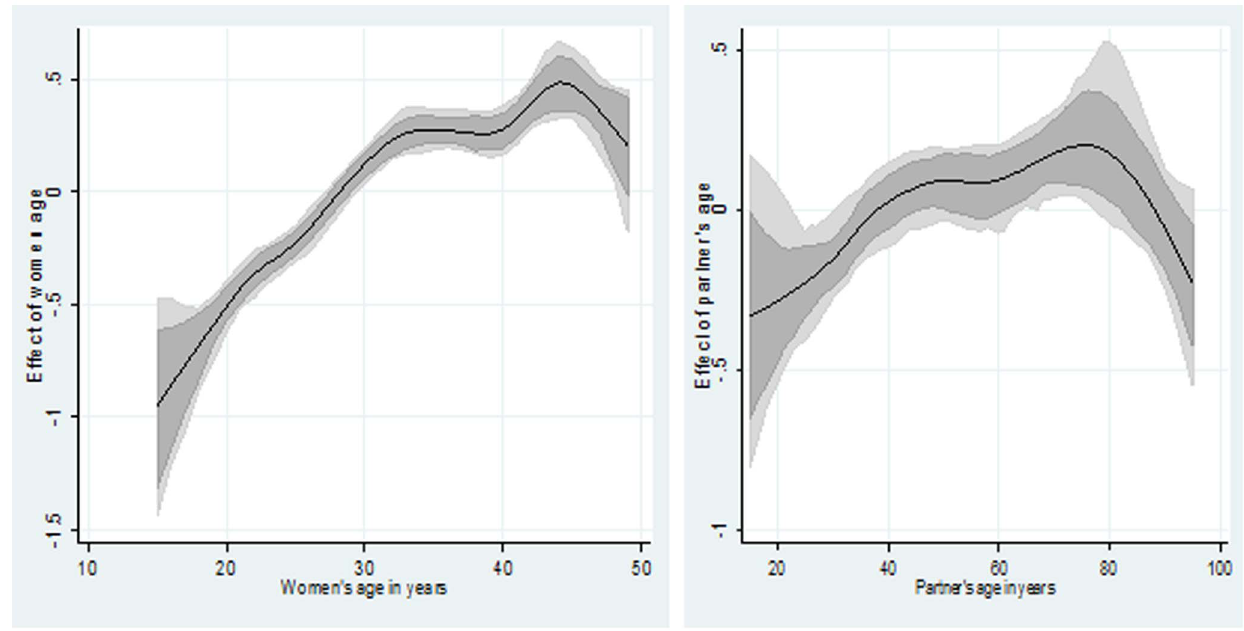
Figure 2. Estimated nonparametric effect of respondent (left) and partner’s (right) age on obesity/overweight. Shown is the posterior mean within 80% credible regions.